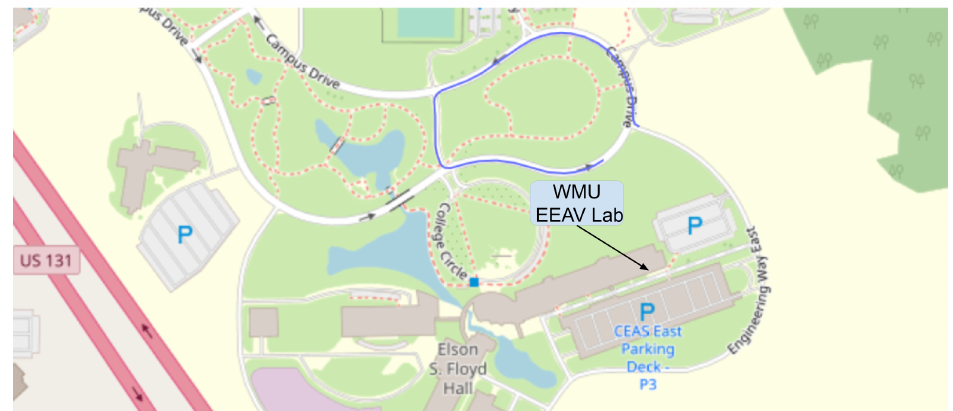
Figure 22. Live data of the Ego vehicle’s position (latitude and longitude) using the Swift Navigation Duro, displayed using OpenStreetMap.